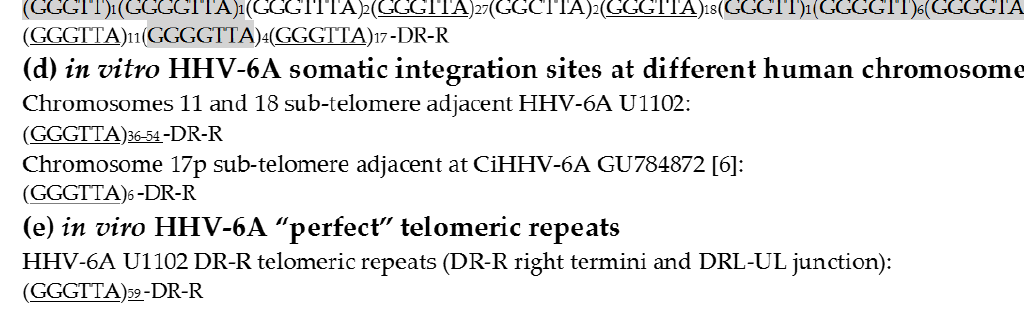
Figure 5. Comparison of the telomeric repeat structure between 12 CiHHV-6A integrated at chromosome 17p subtelomere and at different chromosomes 18 and 10. The repeat structures were determined and grouped into ( a ) In vivo virus genome integration sites at 17p telomeric repeat structure (including the 12 integration sites characterized here); ( b ) in vivo human 17p telomeric repeat structure at the integration site without virus genome; ( c ) in vitro derived human virus genome integration sites; ( d ) in vivo virus genome integration sites at chromosome 10q and ( e ) in viro , the perfect telomeric repeats in the exogenous virus towards the right termini prior to chromosomal integration. Imperfect repeats derived from the human subtelomeric region are shaded. The length differ in the number of perfect telomeric repeats in the center as shown. Comparisons are shown to two previously described integration sites at 17p with similar structure as well as to the distinct integration site in chromosome 10 and the in vitro integration sites at chromosome 18. Of the 12 integration sites at 17p characterized here, the largest 5055, has accession number TBA. Two previous HHV-6A 17p integration sites: HGDP0628 [10], GU784872 [6]; Chromosome 17 subtelomere, complete sequence,